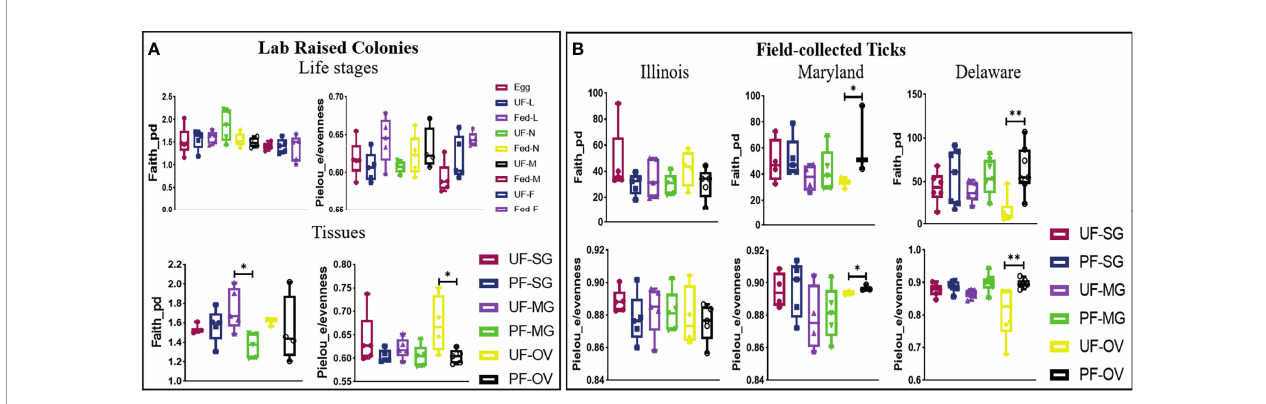
FIGURE 4 | Alpha-diversity metrics. Richness (Faith_pd) and evenness (Pielou_e) index for (A) laboratory-raised tick tissues and developmental stages and (B) fi eld collected tick tissues. Each point on the box plot represents an individual tick or tissue replicate. Asterisks designate signi fi cance level as follows ** p ≤ 0.01, * p ≤ 0.05.